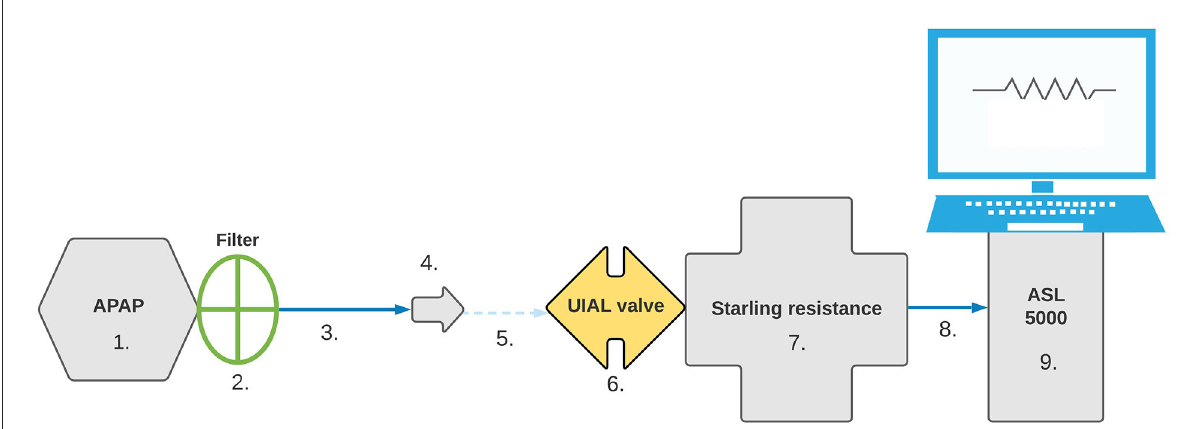
FIGURE1 Bench test setup. Configuration was set in the following order: 1. APAP device, 2. Filter, 3. 180cm SlimLine TM tubing (ResMed TM , San Diego, USA), 4. Whisper Swivel TM II exhalation port (Philips-Respironics TM , Murrysville, USA), 5. Connector, 6. UIAL valve, 7. Starling Resistance, 8. Connector, 9. ASL 5000 TM